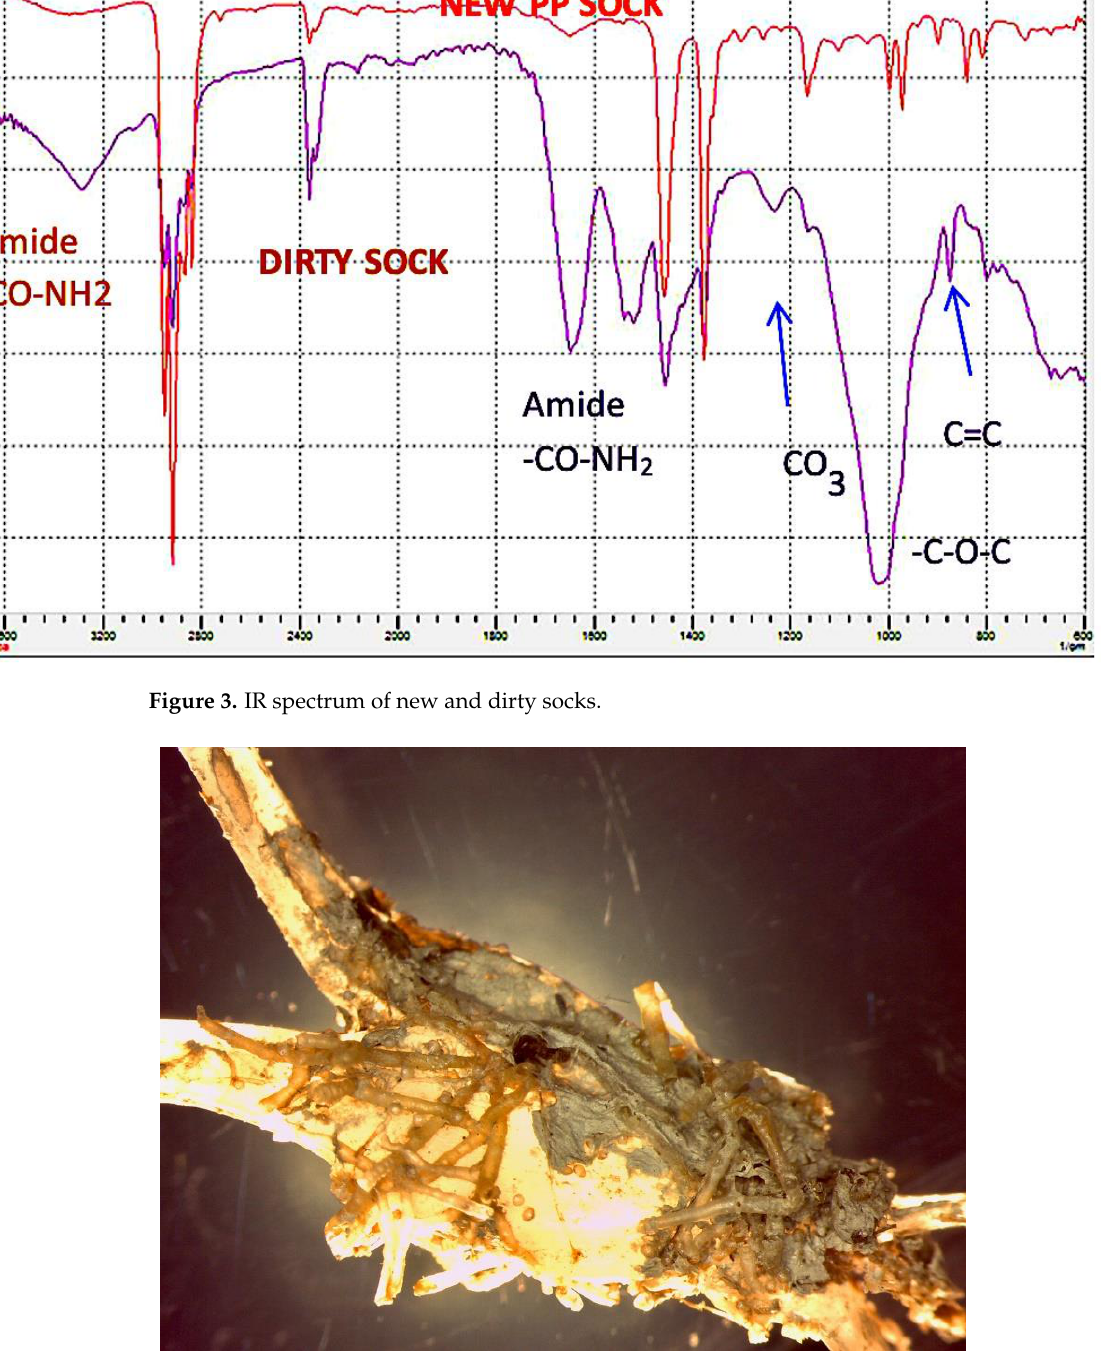
Figure 4. An example of the adhered materials on the sock surface.